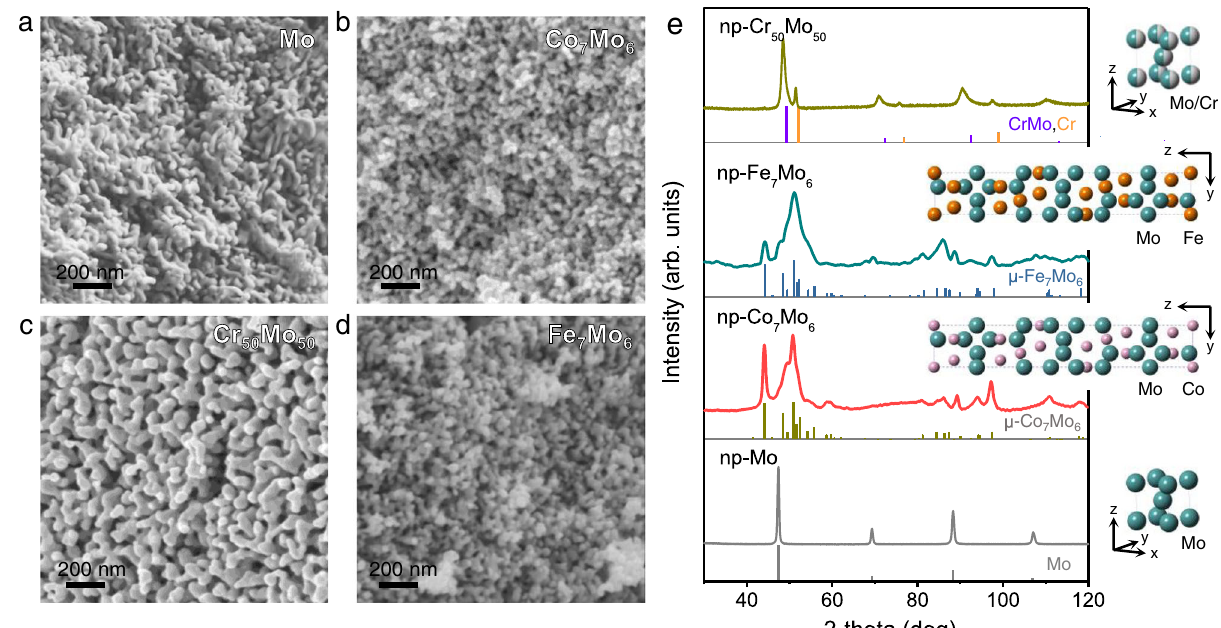
Fig. 2 | Structural characterization of the nanoporous intermetallic com- pounds (or alloys). SEM images of a np-Mo, b np-Co 7 Mo 6 , c np-Cr 50 Mo 50 and d np-Fe 7 Mo 6 prepared by LMD at 973K for 120s . e XRD patterns of the np-Mo, np-Co 7 Mo 6 , np-Cr 50 Mo 50 , and np-Fe 7 Mo 6 . Standard patterns of Mo (PDF#42-